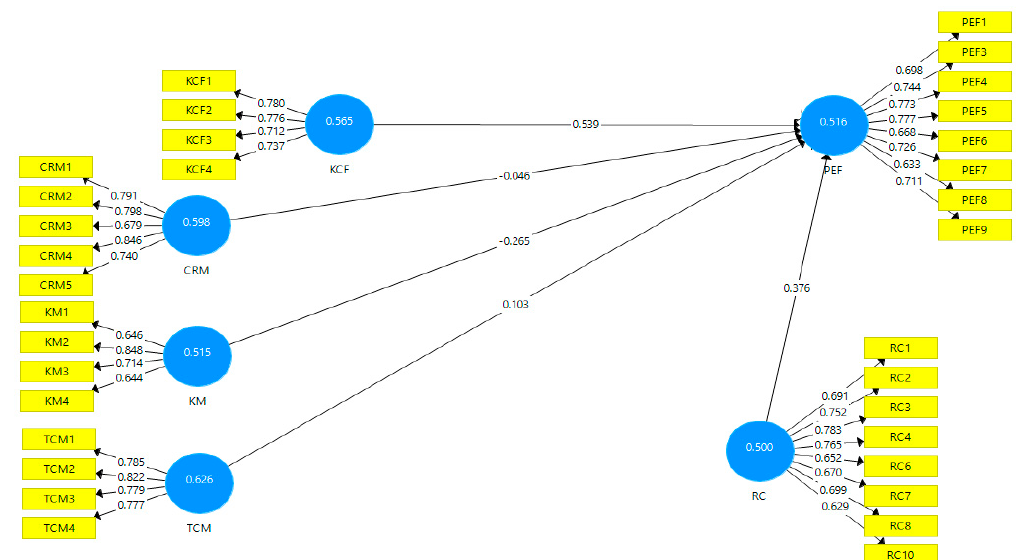
Figure 2. Assessment of the measurement model.